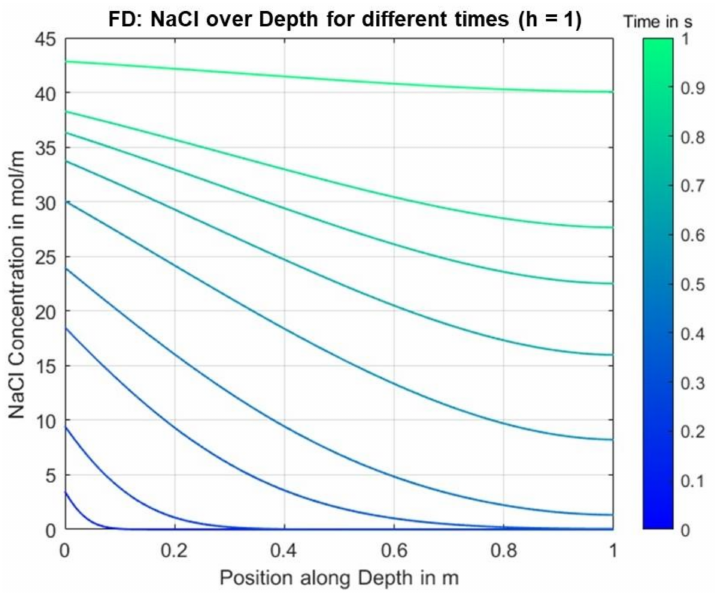
Figure 5. Finite differences solution results for the concentration over position for different times.